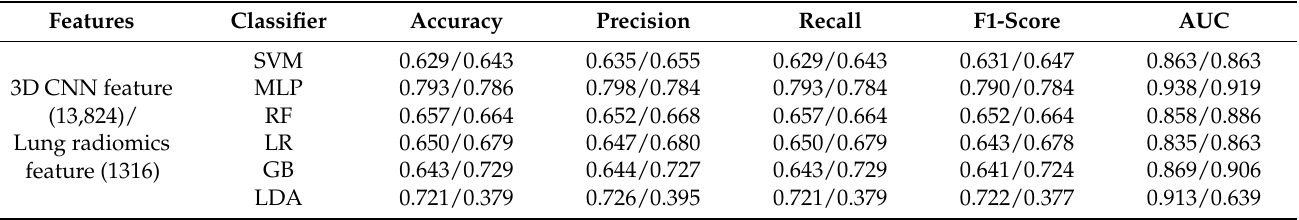
Table 2. The different ML classifiers’ performance on the test set of original 3D CNN features (13,824)/lung radiomics features (1316) in Experiment